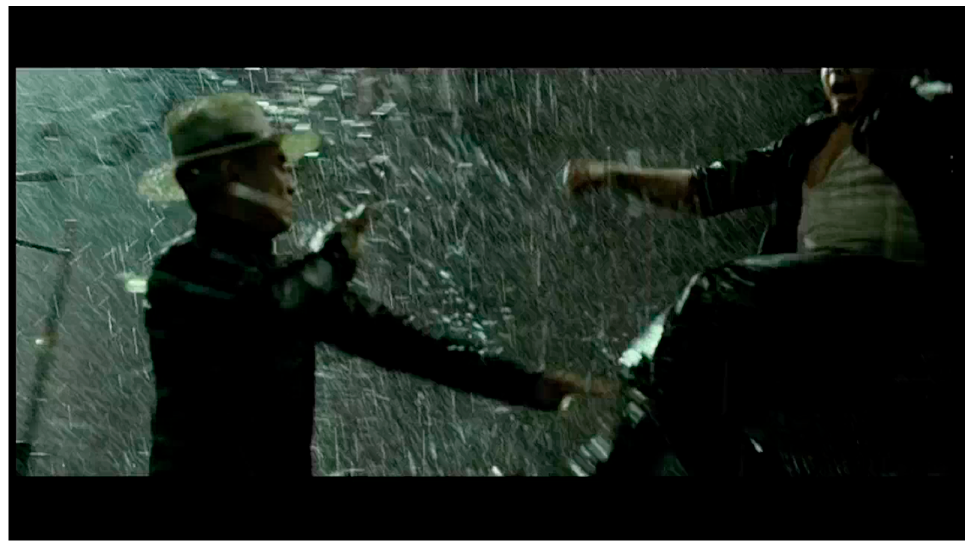
Figure 9. Two axes of action in the frame that ricochet off each other. Frame capture, The Grandmaster (Wong 2013).